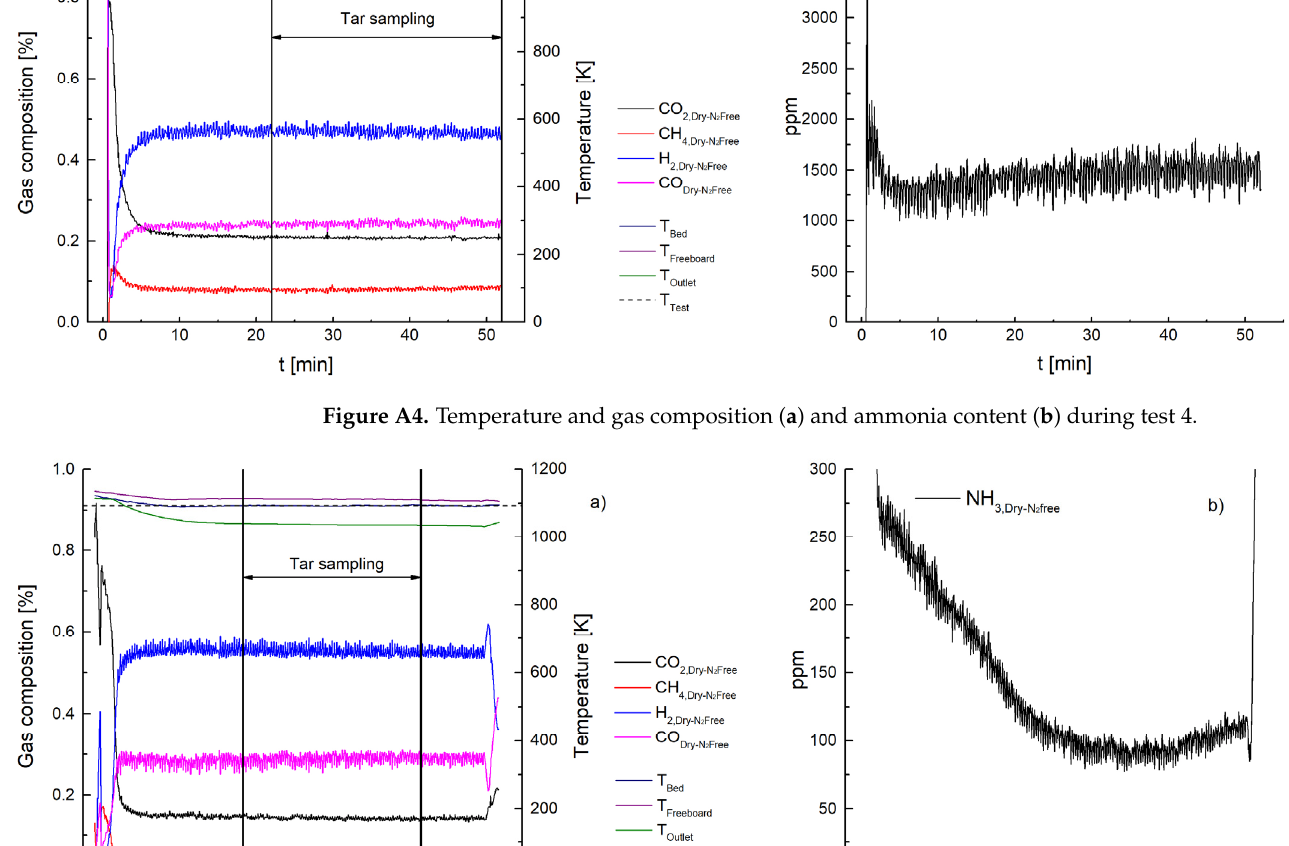
Figure A5. Temperature and gas composition ( a ) and ammonia content ( b ) during test 6.